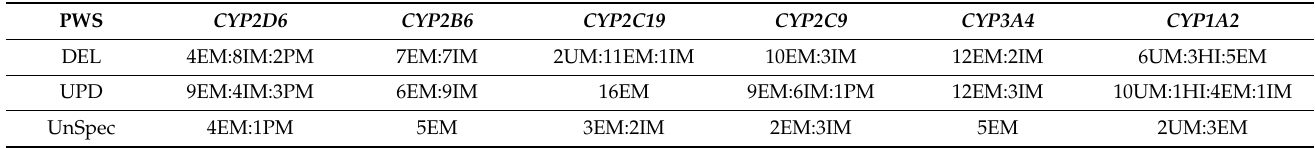
Table A5. Ratios of Cytochrome P450 phenotypes among PWS genetic